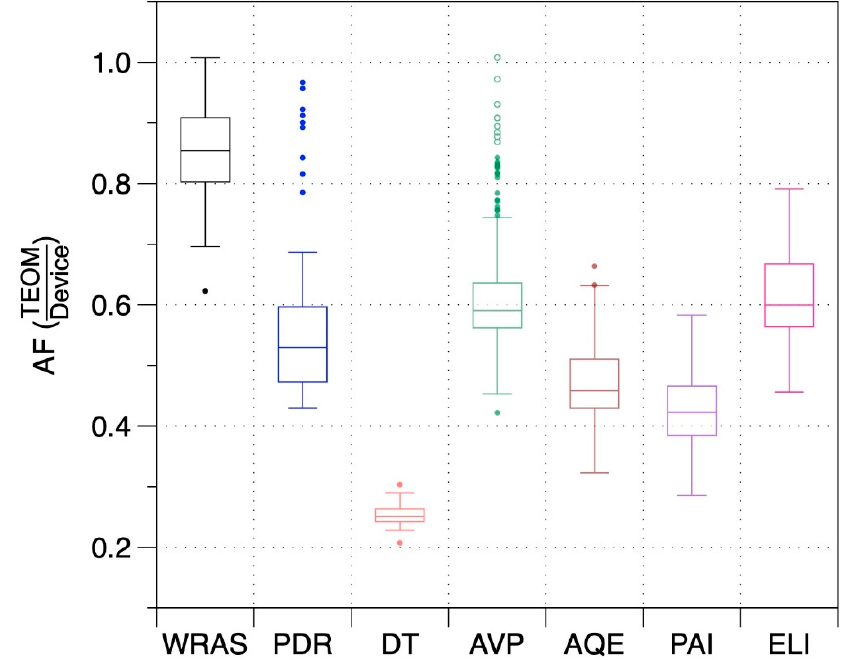
Figure 3. Distributions of 4-h average adjustment factors determined from measurements in a naturally ventilated lab over 13 days of elevated smoke from the Camp Fire. ventilated lab over 13 days of elevated smoke from the Camp